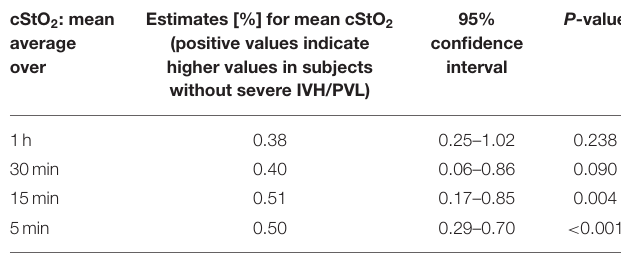
TABLE 3 | ANOVA with a mixed linear model. cStO 2 : mean average